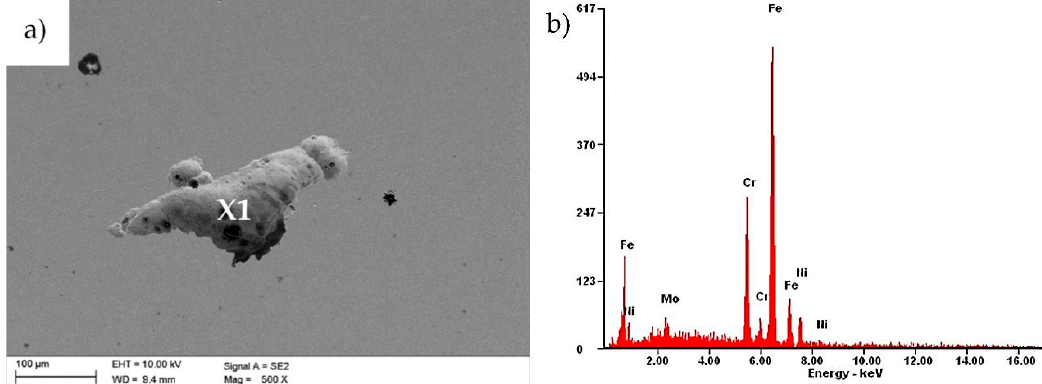
Figure 11. ( a ) Surface morphology after an electrochemical examination of an uncoated sample; ( b ) EDS spectrum from the microarea X1.